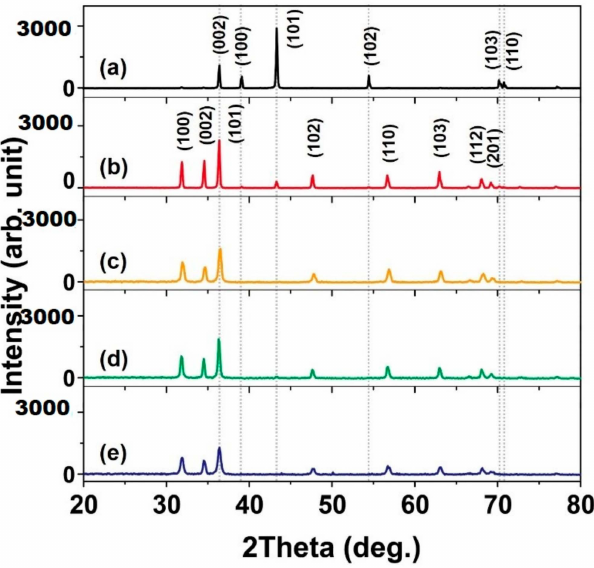
Figure 2. XRD spectra of ( a ) Zn powder and synthesized ZnO nanomaterials using ( b ) compressed air, ( c ) high-purity air, ( d ) O 2 , and ( e ) O 2 / N 2 mixed